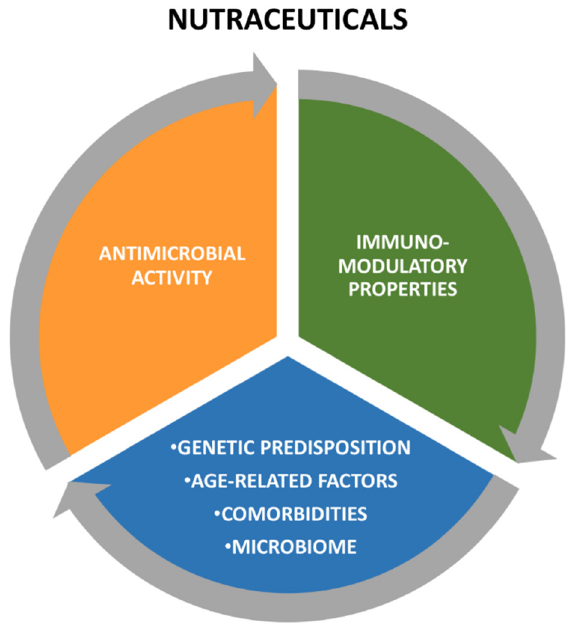
Figure 3. Interaction between individual substrate and nutraceuticals.